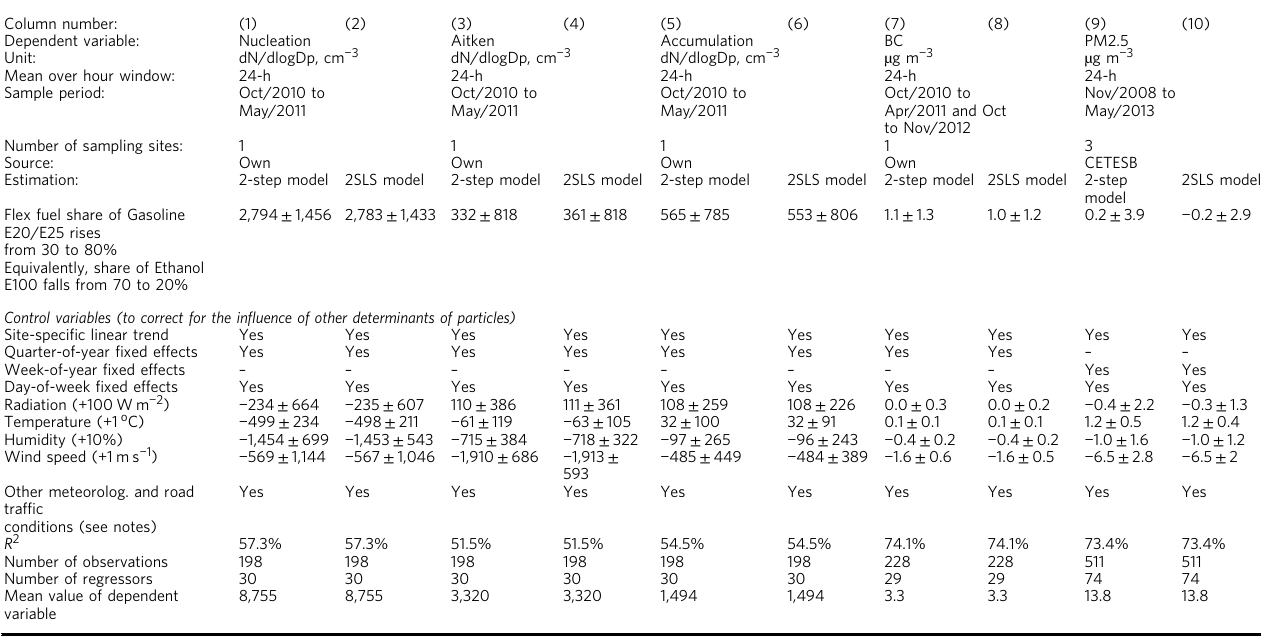
Table 3 Changes to 24-h mean particle concentrations associated with variation in the gasoline ‐ ethanol fuel mix Column